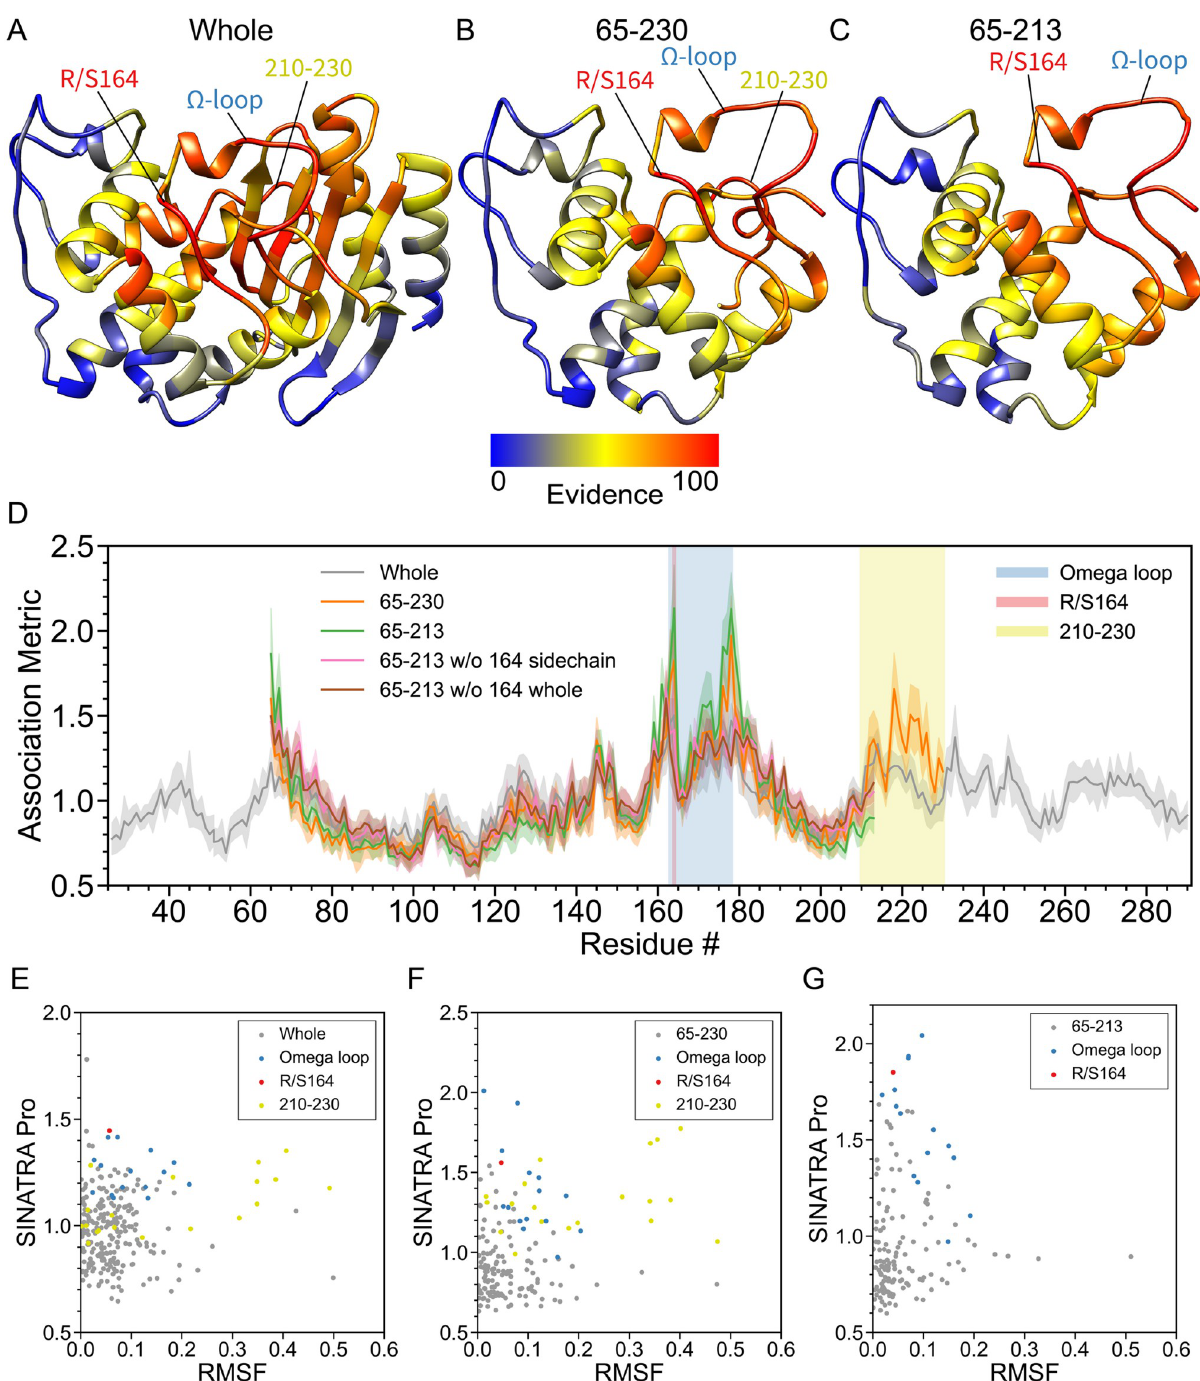
Fig 3. Real data analyses aimed at detecting structural changes in the O -loop of β -lactamase (TEM) induced by an R164S mutation. In this analysis, we compare the molecular dynamic (MD) trajectories of wild-type β -lactamase (TEM) versus R164S mutants [21, 22]. For both phenotypic classes, structural data are drawn from equally spaced intervals over a 100 ns MD trajectory (e.g., t MD = [0, 1, 2, 3, ... , 99] ns + δ , where δ is a time offset parameter). Altogether, we have a final dataset of N = 2000 protein structures in the study: 100 ns long interval × 10 different choices δ = {0.0, 0.1, 0.2, ... , 0.9} ns × 2 phenotypic classes (wild-type versus mutant). This figure depicts results after applying SINATRA Pro using parameters { r = 6.0 Å , c = 20, d = 8, θ = 0.80, l = 120} chosen via a grid search. The heatmaps in panels (A) - (C) highlight residue evidence potential on a scale from [0–100]. A maximum of 100 represents the threshold at which the first residue of the protein is reconstructed, while 0 denotes the threshold when the last residue is reconstructed. Panel (A) shows the residue-level evidence potential when applying SINATRA Pro to the whole protein, while panels (B) and (C)